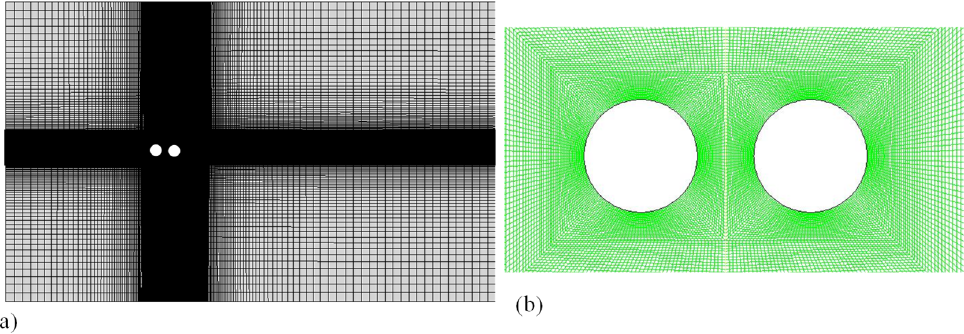
Figure 2. ( a ) Grid system in the computational domain and ( b ) close-up view of grids around the cylinders. L/D =